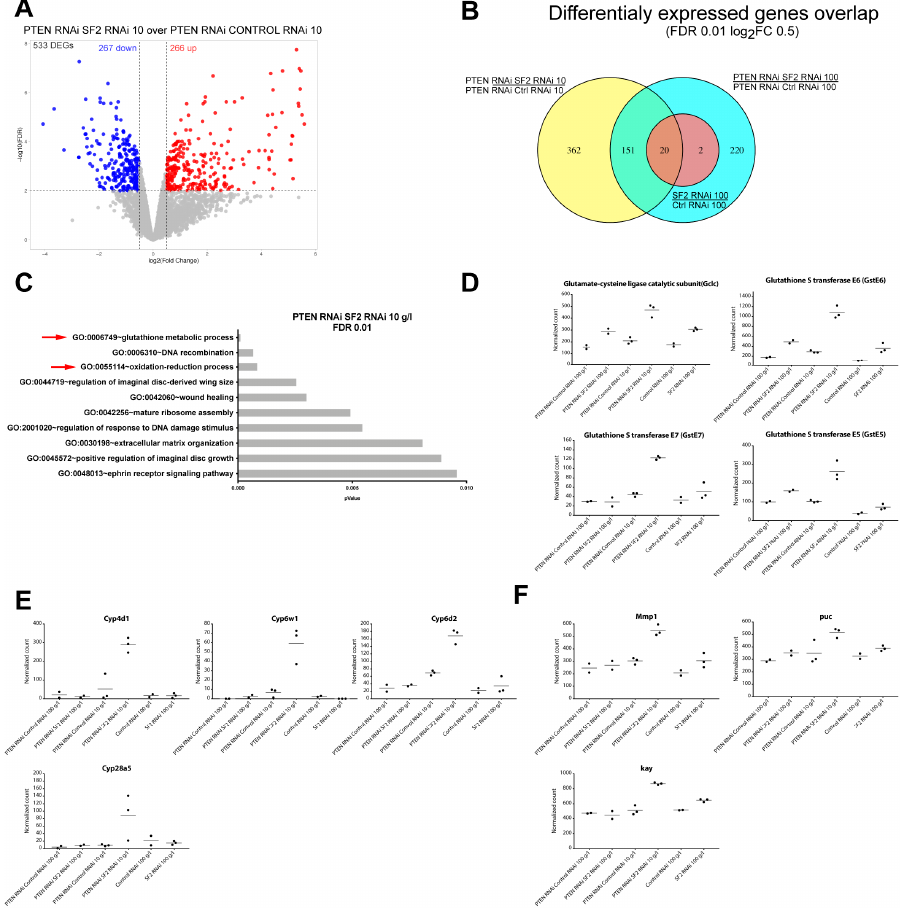
Figure 5. DEGs in Pten SF2 -deficient eye imaginal discs upon NR are connected to cellular stress. ( A ) DEGs in PTEN RNAi SF2 RNAi discs in 10 g/l conditions. ( B ) Overlap of DEGs detected in PTEN RNAi SF2 RNAi 10 g/l, PTEN RNAi SF2 RNAi 100 g/l and SF2 RNAi 100 g/l. ( C ) GO enrichment analysis of all DEGs (FDR 0.01) in PTEN RNAi SF2 RNAi 10 g/l. ( D ) Chosen DEGs from GO category “glutathione metabolism”. ( E ) Chosen DEGs from GO category “oxidation-reduction process”. ( F ) Downstream targets of JNK.